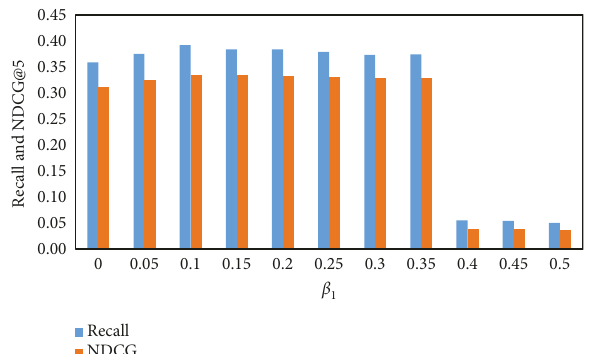
Figure 9: Comparison of Recall@5 and NDCG@5 with different β